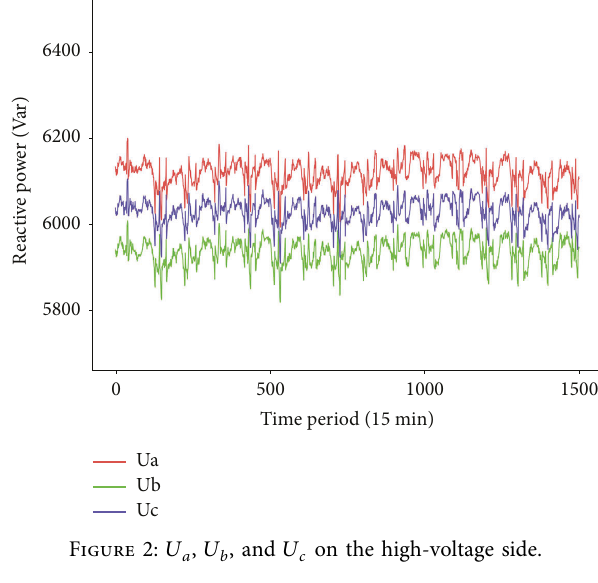
U U a , b , and c on the high-voltage side.